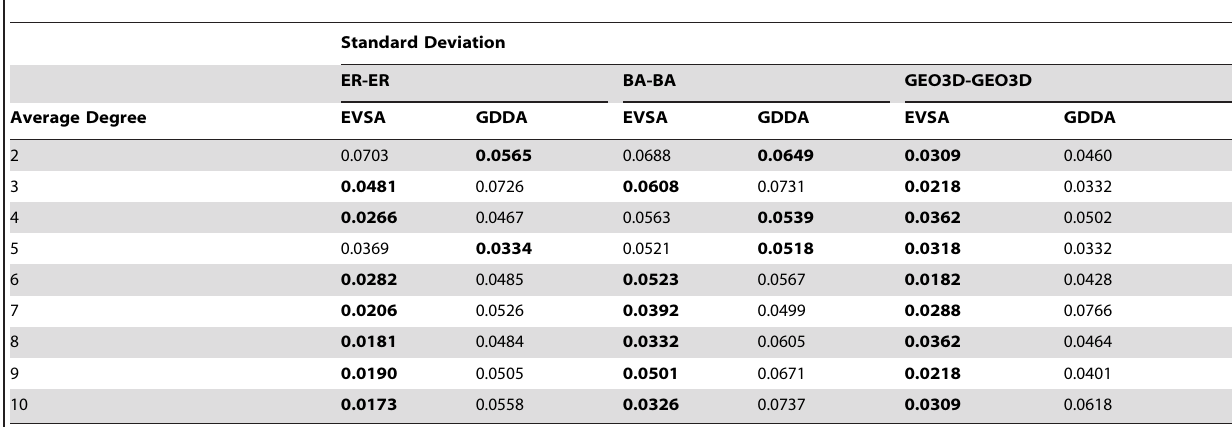
Table 4. Standard deviation of EVSA, GDDA in same model comparison over various average degrees.